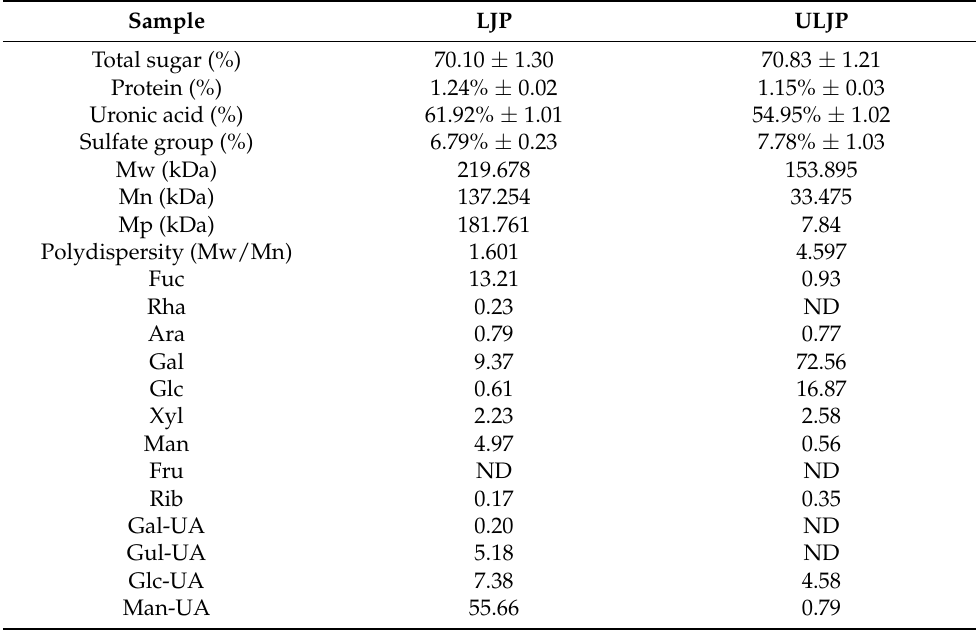
Table 1. Chemical constituents, molecular weight parameters and monosaccharide compositions of LJP and ULJP.